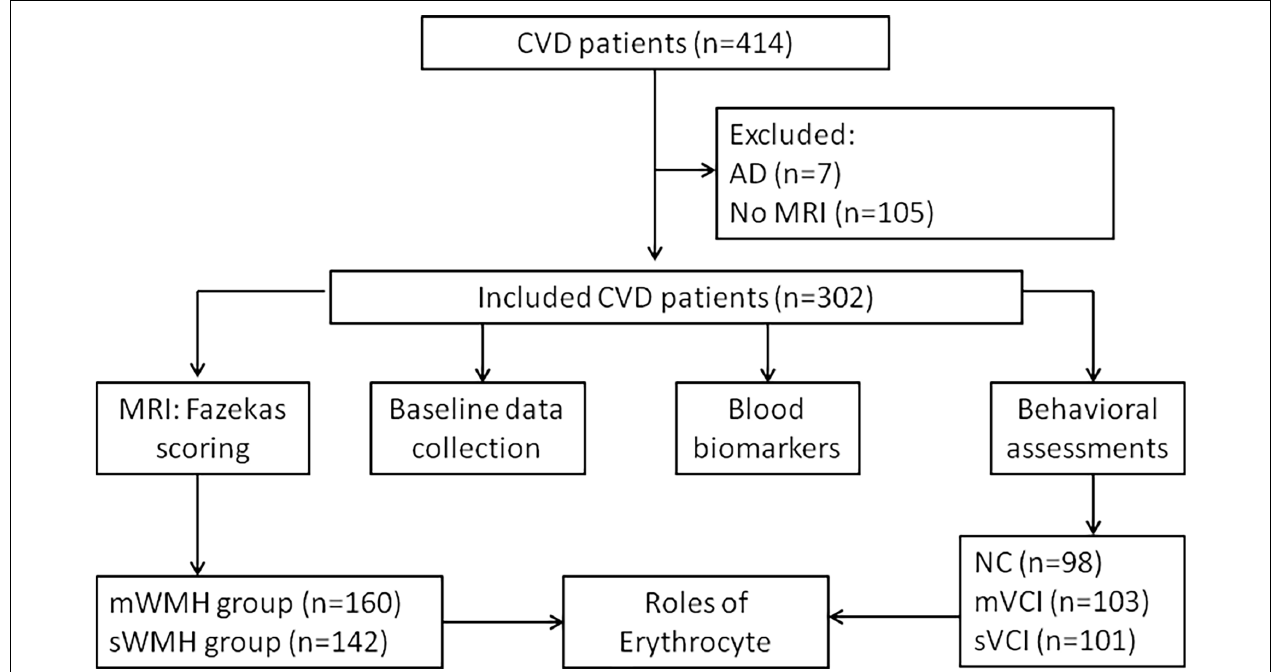
FIGURE 1 | Study flow chart. Four-hundred and fourteen patients with CVD were enrolled, seven patients with suspected AD and 105 patients without MRI data were excluded, and 302 patients were included. Baseline demographic data, blood biomarkers, MRI images, and behavioral scores were collected. The patients were divided into mWMH and sWMH groups based on Fazekas scoring. A model was constructed to predict the diagnostic value of erythrocytes for VCI. AD, Alzheimer’s disease; CVD, cerebrovascular disease; mVCI, mild vascular cognitive impairment; mWMH, mild white matter hyperintensities; NC, normal cognition; sWMH, severe white matter hyperintensities; sVCI, severe vascular cognitive impairment; VCI, vascular cognitive